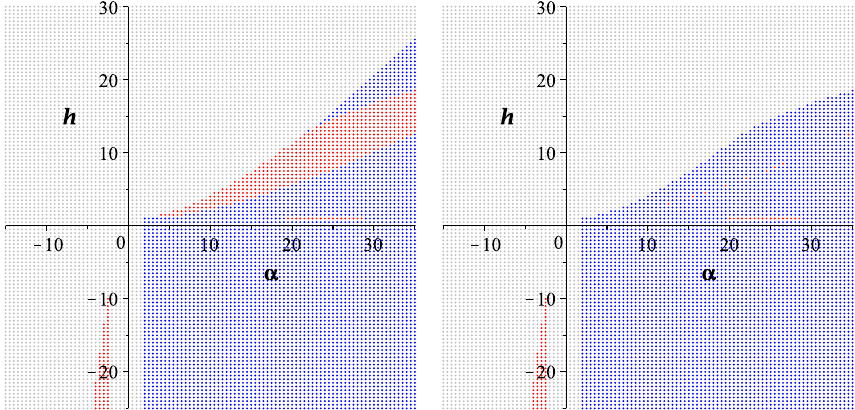
Figure 1 . Possible critical points in ( (cid:11); h ) parameter space for k = 1 , (cid:15) = +1 and q = 0 : here red, blue, and grey points indicate two, one, and zero (possible) critical points, respectively. Left : possible critical points satisfying entropy and pressure conditions. Right : actual critical